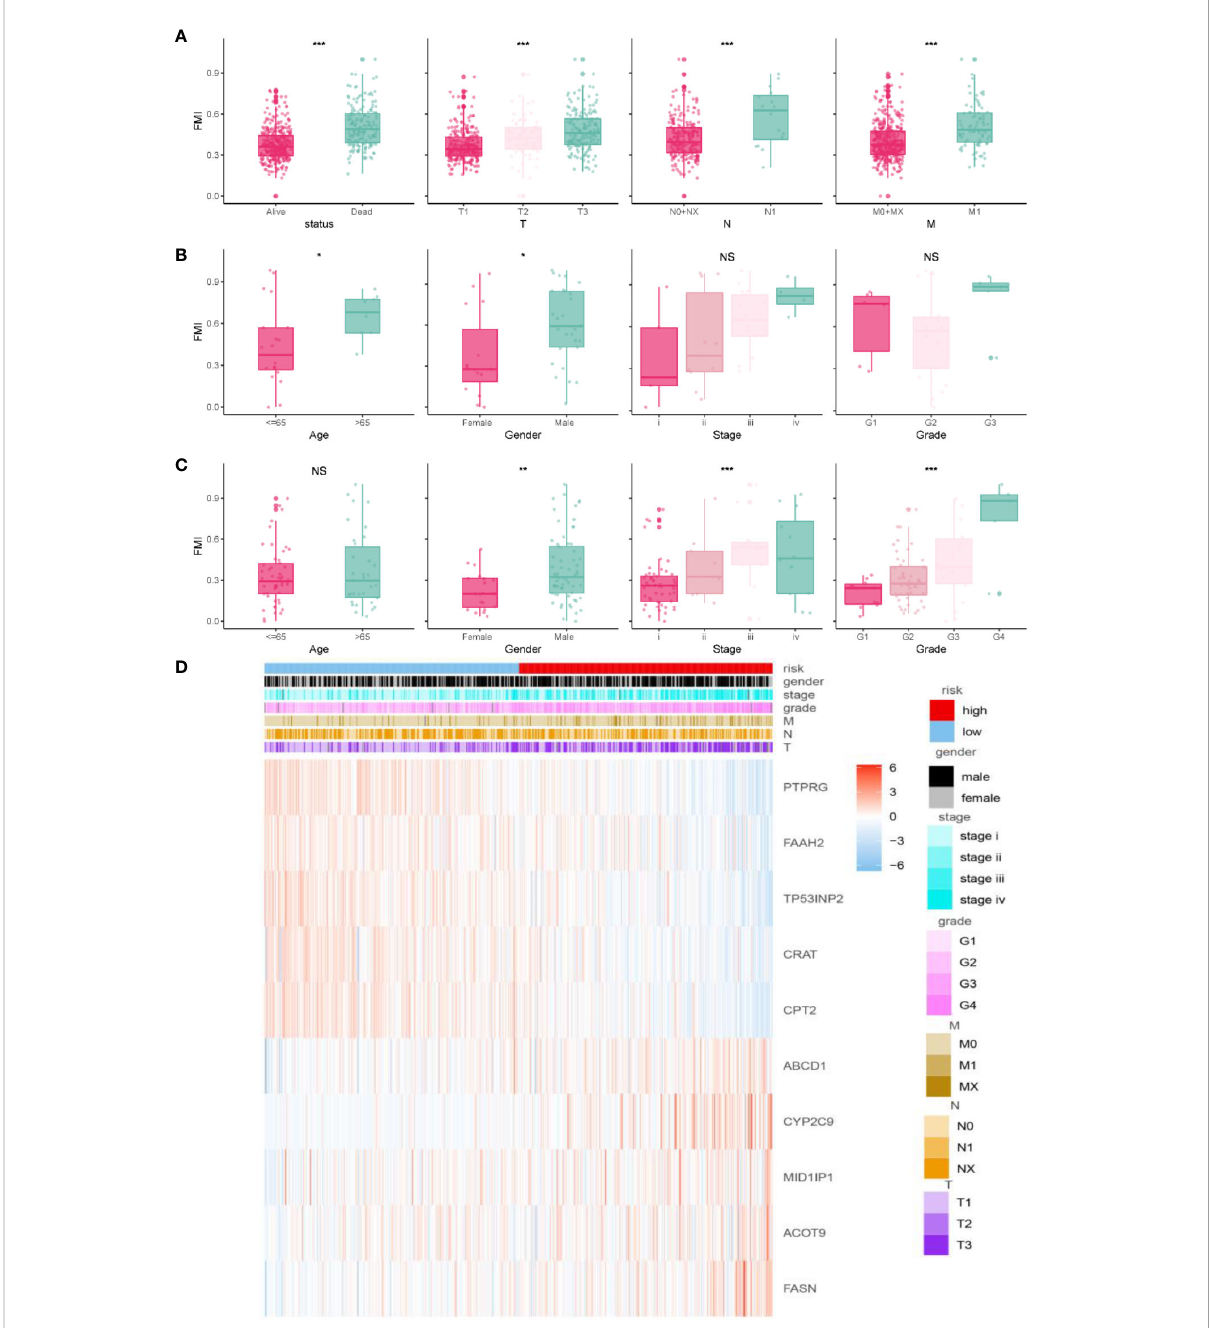
FIGURE 4 Correlation analysis of clinical features and FMI. Association between adjusted FMI and different clinical parameters in the TGCA-KIRC. (A) , E- MTAB-1980 (B) , and GSE22541 (C) cohorts. Heatmaps of the correlations between FMI and clinical parameters in the TGCA-ccRCC cohort (D) . * P < 0.05; ** P < 0.01; *** P < 0.001; ns means no signi fi